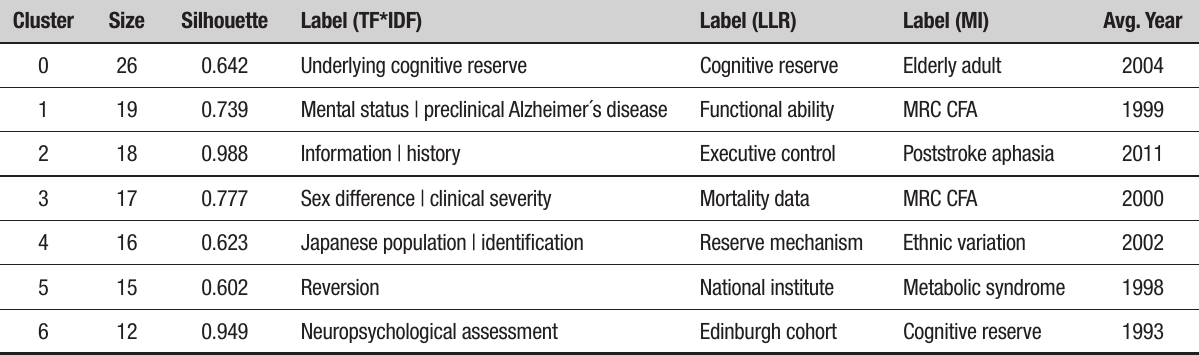
Table 1. Major clusters of co-citation